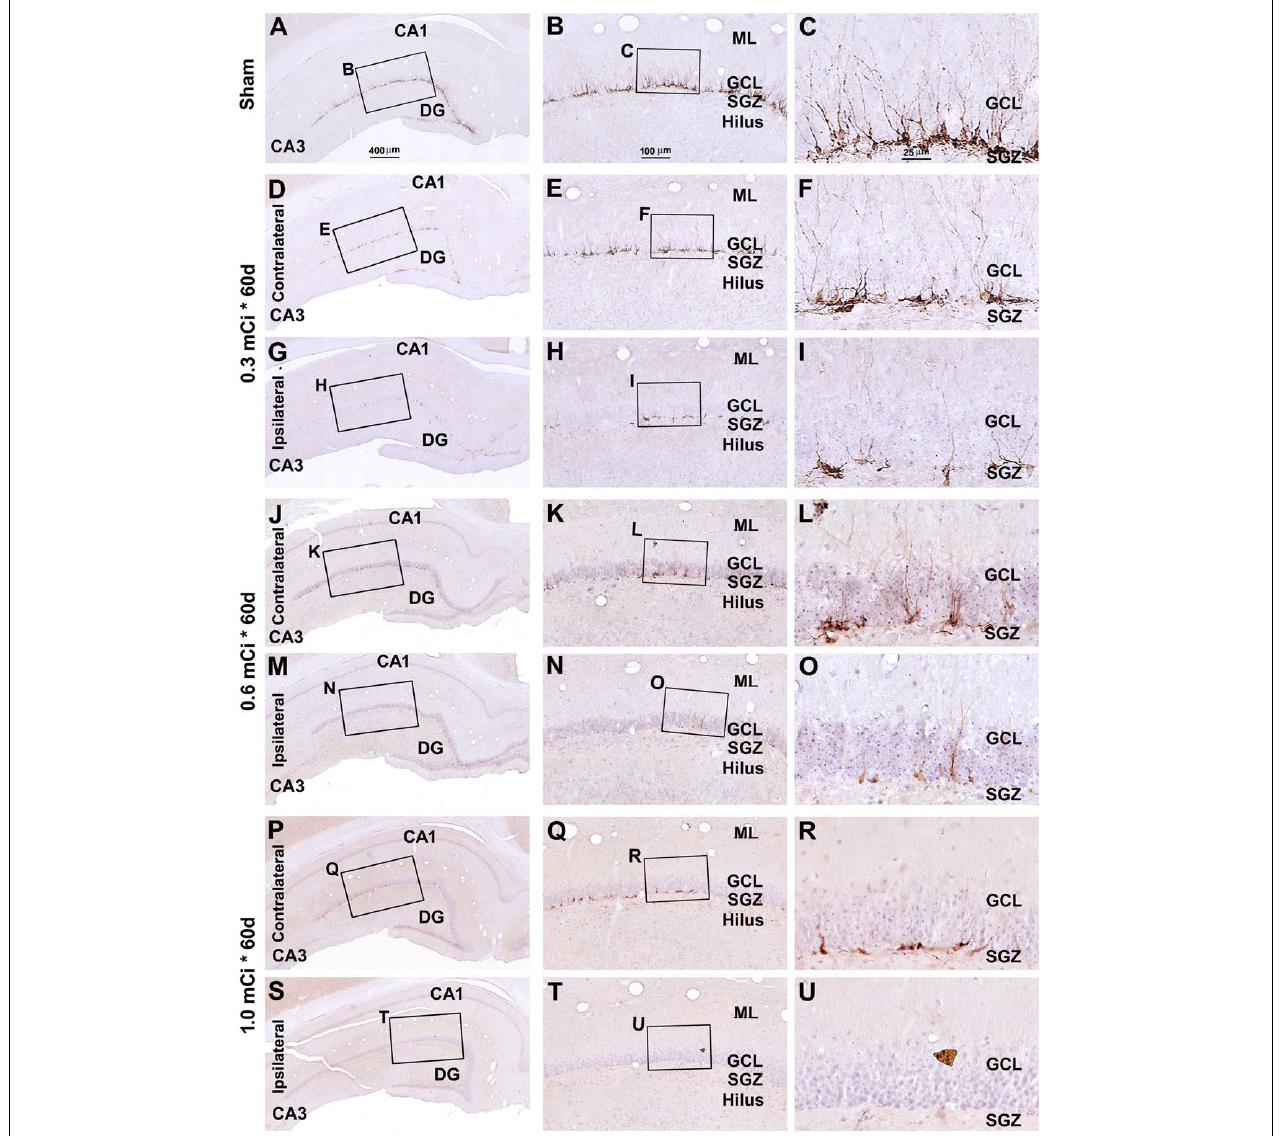
FIGURE 8 | Characterization of DCX labeling in the ipsilateral and contralateral hippocampal dentate gyrus in animals with 0.3–1.0-mCi 125 I seed radiation for 60 days relative to the sham control. Images of DCX immunolabeling (brown) with hematoxylin counterstain (blue) from representative animals are shown, with panel arrangements as indicated. DCX + cells in the SGZ appear reduced in radiation groups relative to the sham group, as are their dendritic branches (right panels). Compared with Figure 4, the number and morphology changes of DCX + cells in radiation group are more significant. Abbreviations are as defined in Figure 2 . Scale bar = 400 µ m in (A) applying to (D,G,J,M,P,S) ; equal to 100 µ m for (B,E,H,K,N,Q,T) ; and 25 µ m for (C,F,I,L,O,R,U)